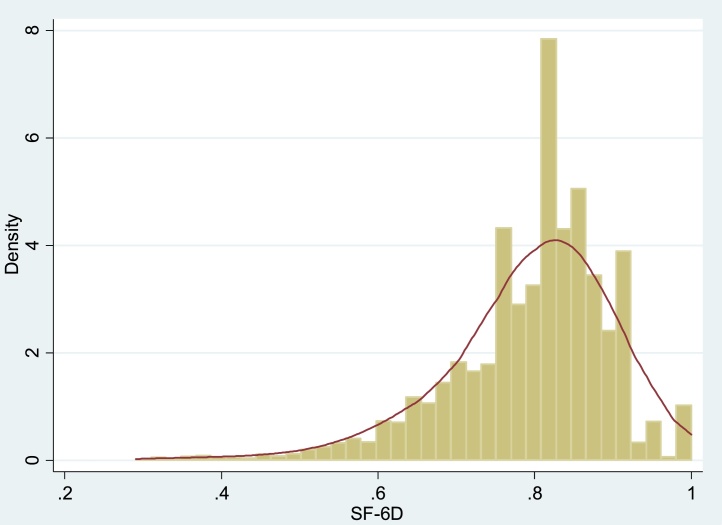
Distribution of self-reported health-related quality of life (SF-6D) measured at age 50.